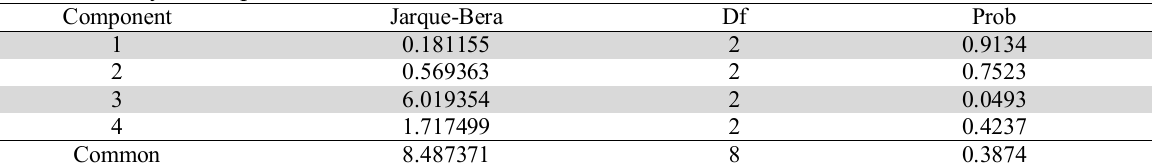
The summary of Jarqe-Bura test